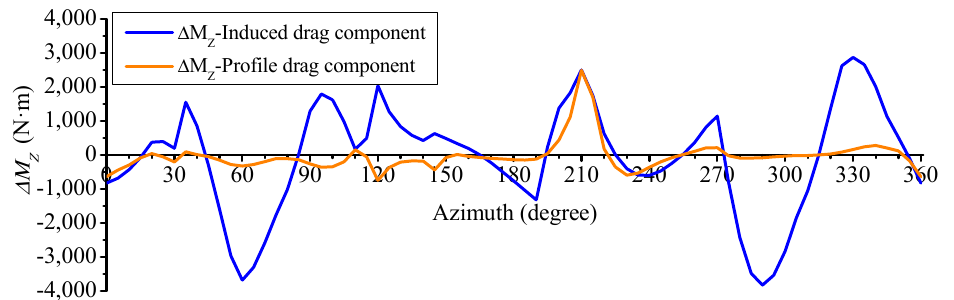
Figure 25. Blade shaft moment increment of the 3-seg control relative to the 2-seg control rotor.